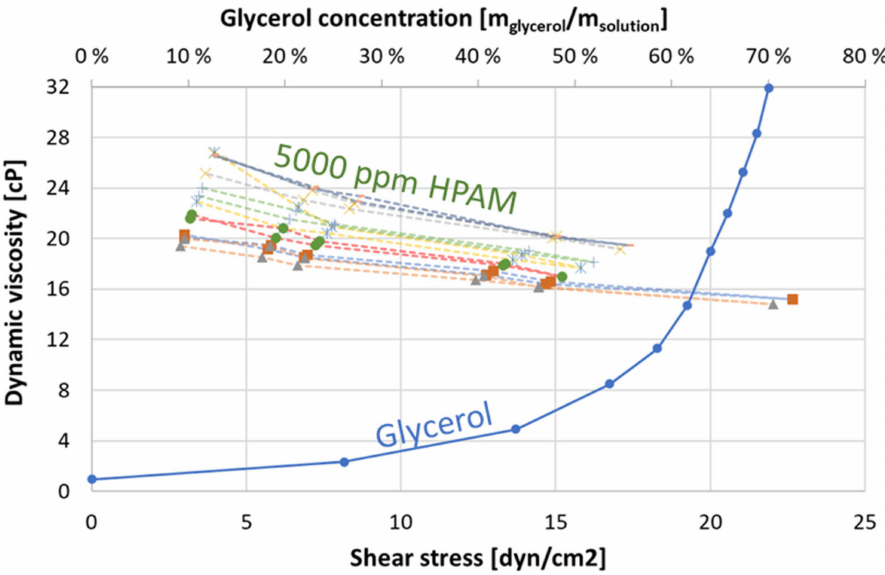
Figure 2. Viscosity ( y -axis) as a function of shear stress for seven different 5000 ppm polymer solutions (primary x -axis), and as a function of concentration for glycerol solutions (secondary x